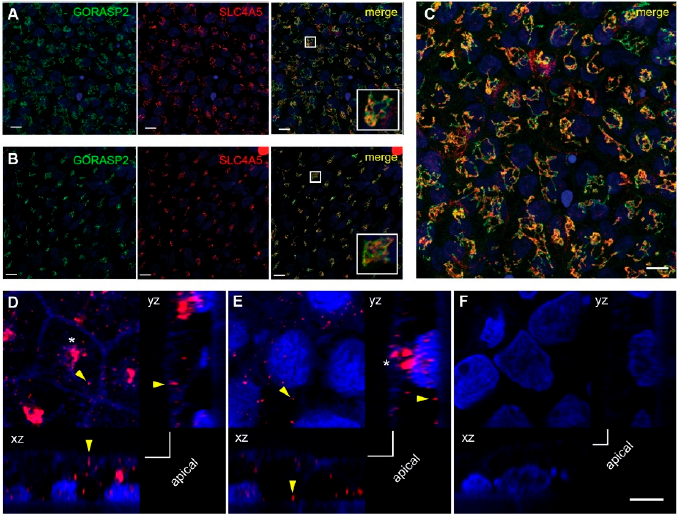
Figure 2. Expression of SLC4A5 in cultured human RPE differentiated from pluripotent stem cells. ( A , B ) Double-label indirect immunofluorescence micrographs of staining for Golgi marker